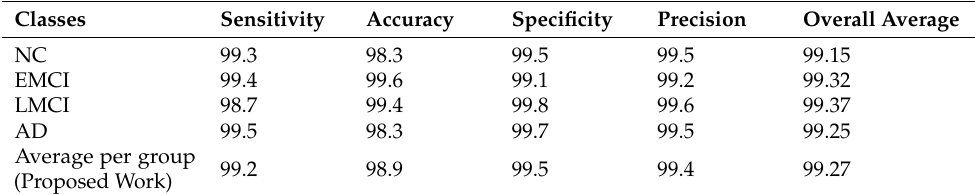
Figure 4. The graphical analysis of the performance of the proposed network. Box plots are shown for the sensitivity, accuracy, specificity and precision for all the four groups (i.e., Group 1–4); each group is comprised of 4 classes (i.e., NC, EMCI, LMCI, and AD). The average is also shown for all groups (i.e., Group 1–4). Table 2. The comparison of the performance in terms of overall accuracy of the PMCAD-Net on various classes, including normal controls (NC), early mild cognitive impairment (EMCI), late mild cognitive impairment (LMCI), and Alzheimer’s disease (AD).